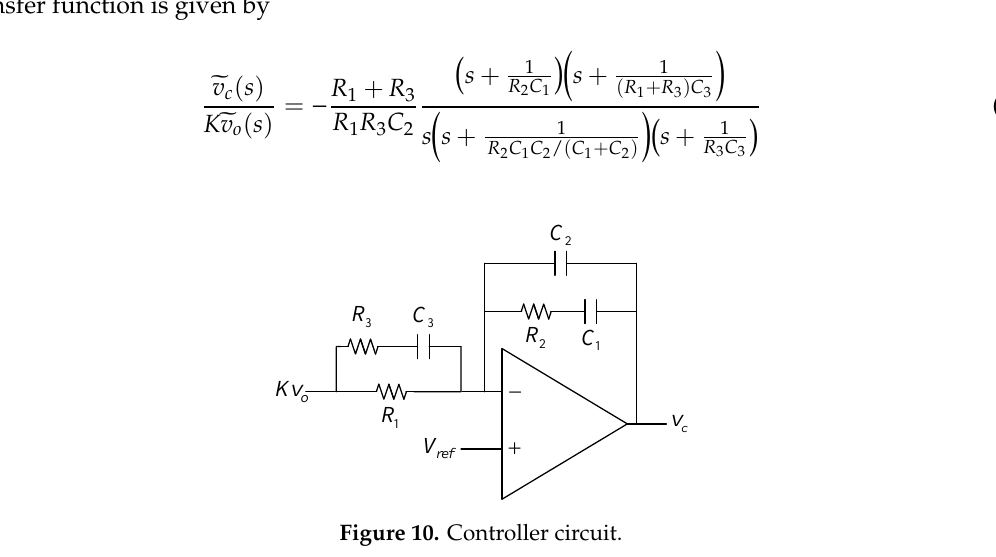
Figure 10. Controller circuit.